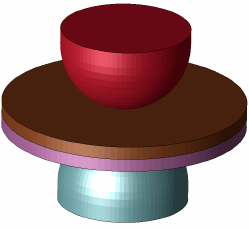
Figure 3. FE model for the process simulation.